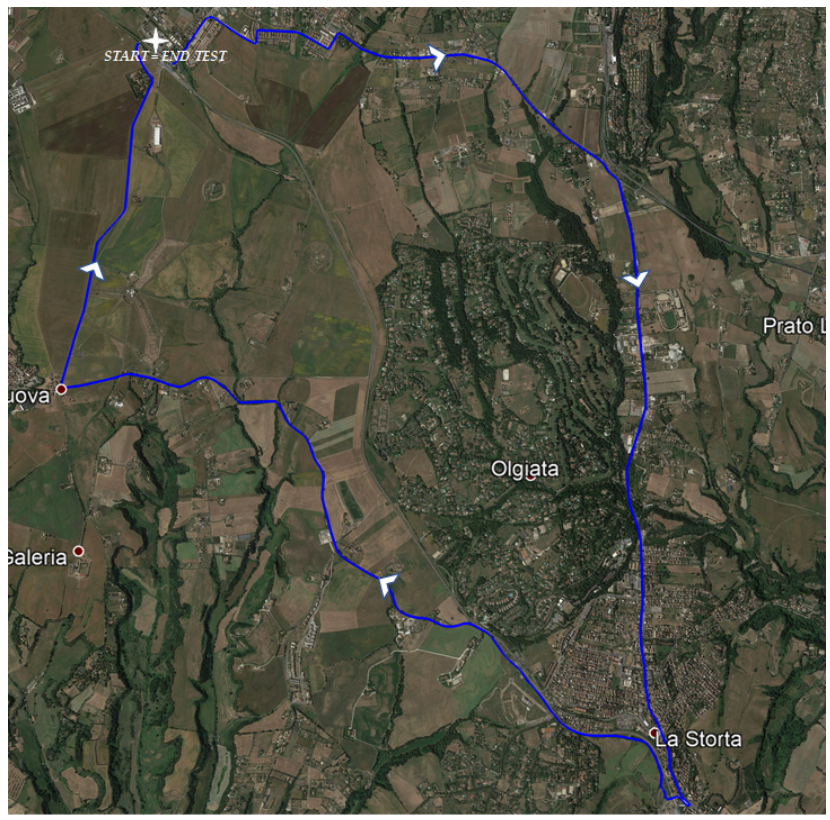
Figure 5. Examined roads and travel direction.